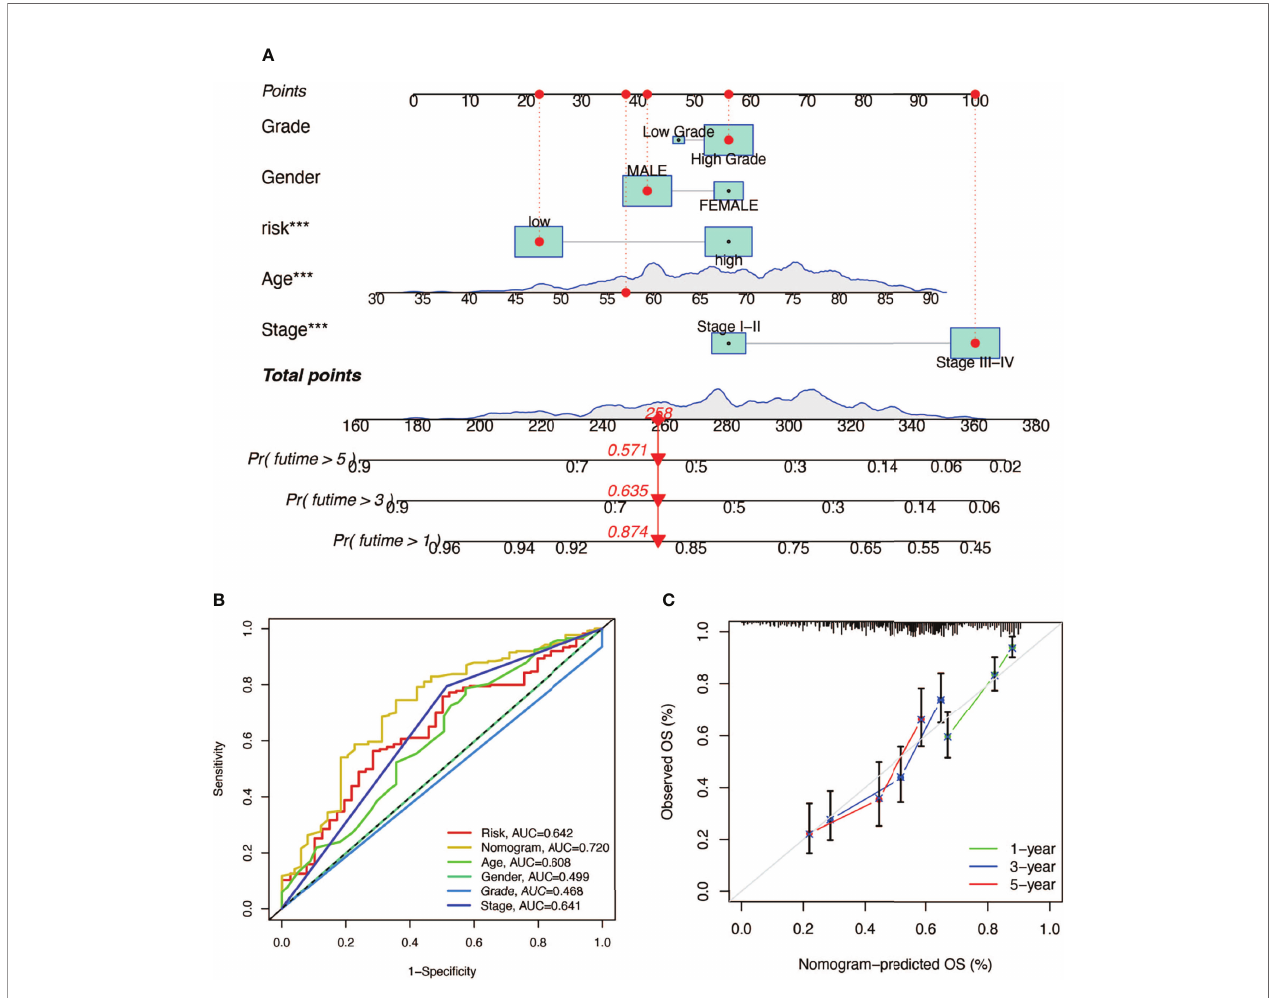
FIGURE 4 | The establishment of a nomogram predicting the prognosis of patients with BCa. (A) Nomogram of a randomly selected patient (*** P < 0.001). (B) AUC curve of the nomogram. (C) Calibration plot of 1-, 3-, and 5-year overall